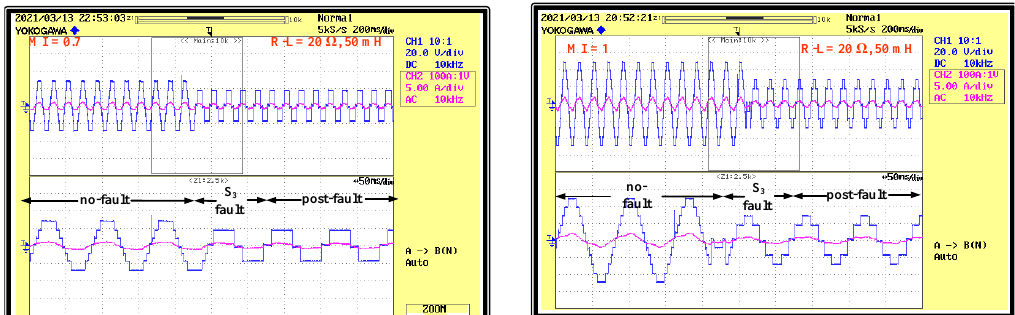
Figure 20. Experimental voltage and current waveforms under S 3 fault.